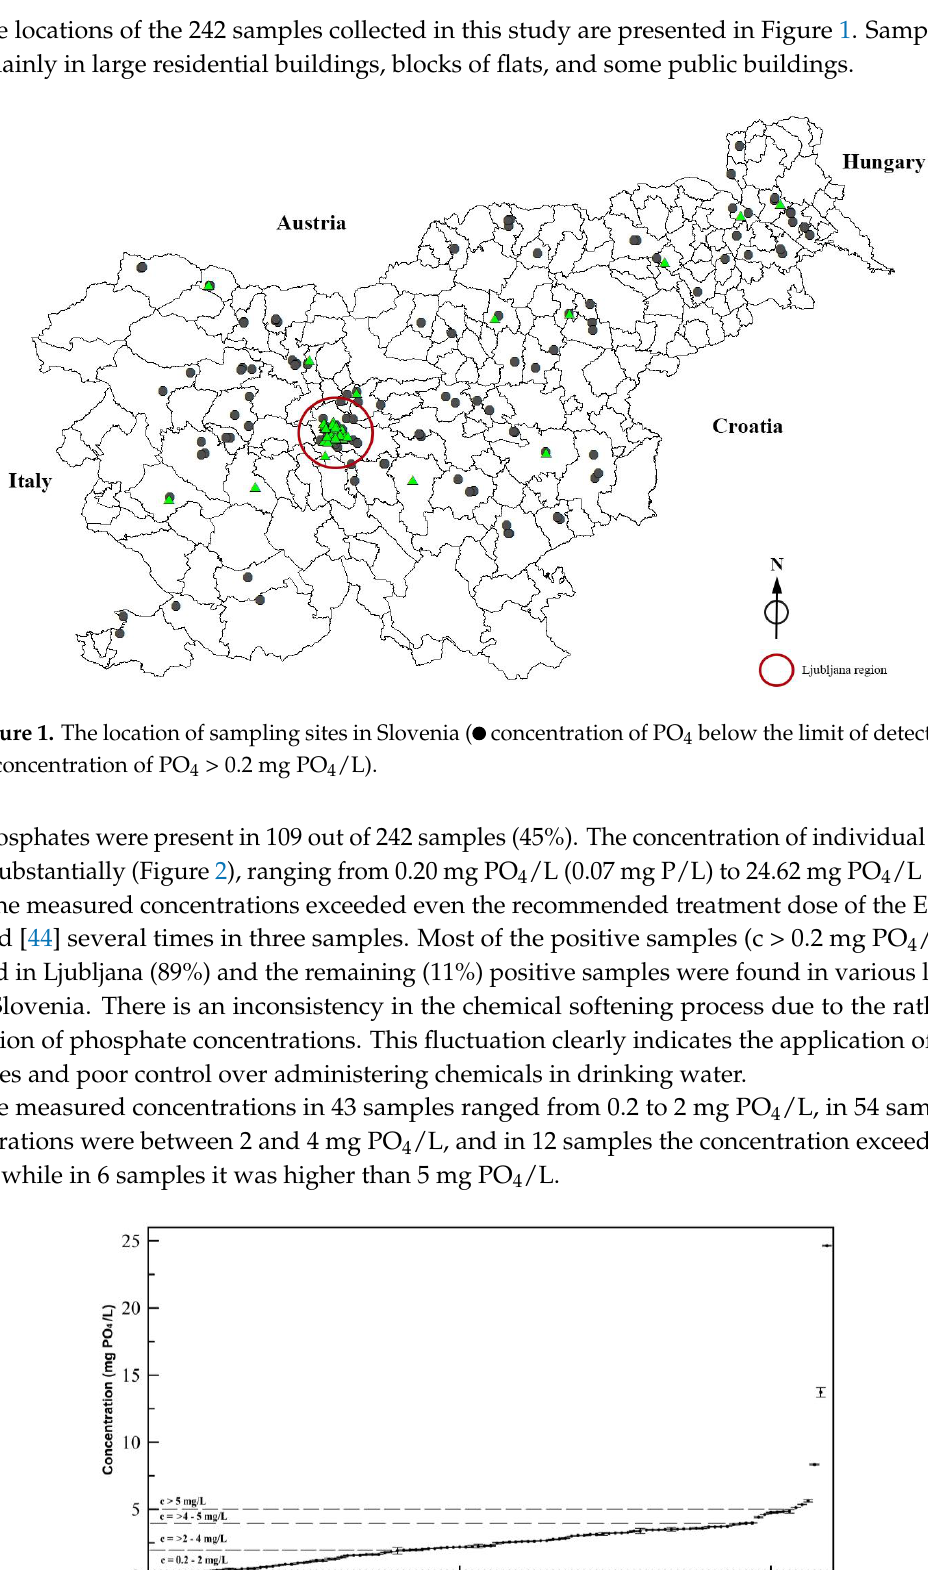
Figure 2. Concentrations of phosphates in mg PO 4 /L (from min. to max. concentration).